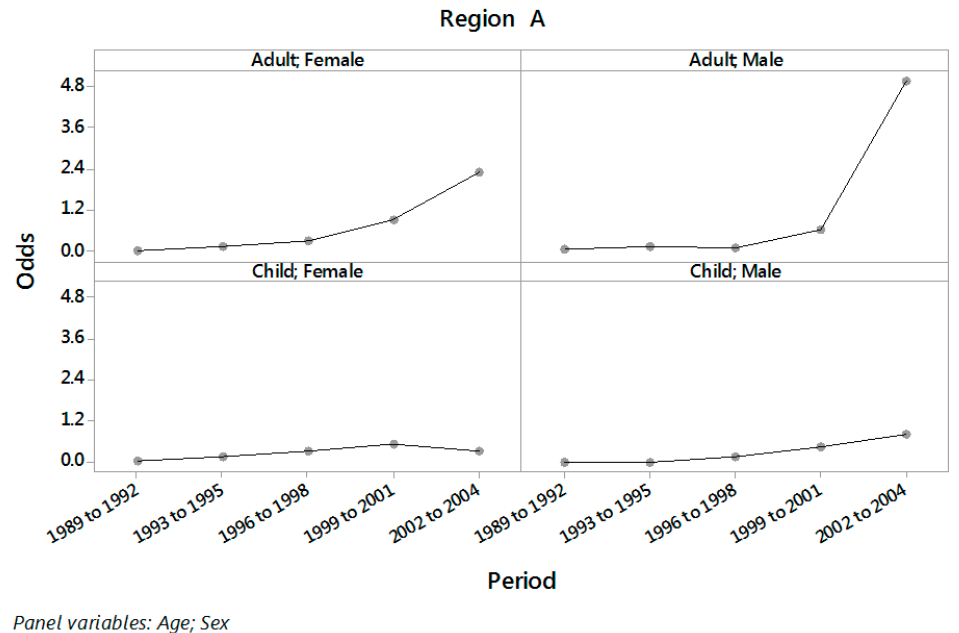
Plots of the odds of PH in Regions A and B (by sex and age) for the different three year periods are displayed in Figures 1 and 2.